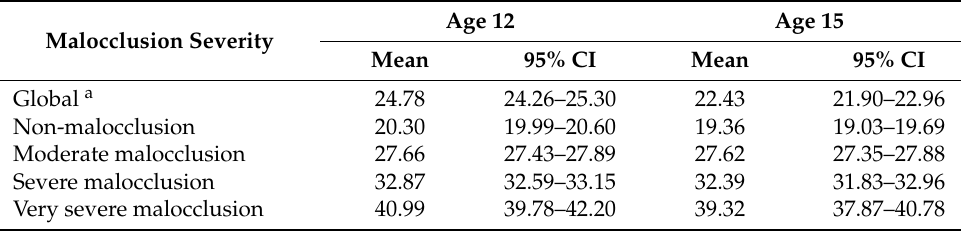
Table 2. Mean Dental Aesthetic Index (DAI) in 12- and 15-year-old